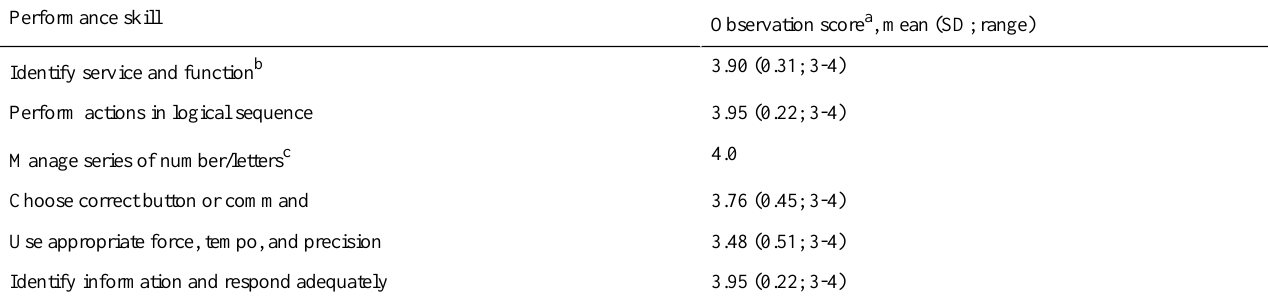
Table 3. Assessment of observable performance skills when using the PsyMate app during the experience sampling method (ESM) training session